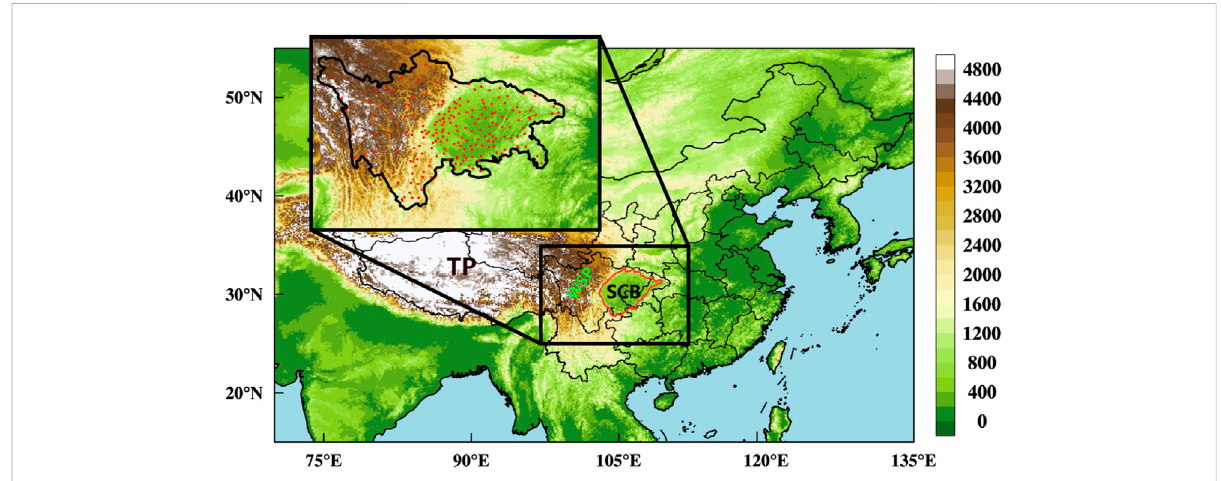
FIGURE 1 Topography map (shading, unit: m) with the locations of TP, WSP, and SCB. The solid red line marks the basin boundary with a topographic elevation of 750 m. The 191 meteorological stations used to collect visibility and wind speed are marked with red